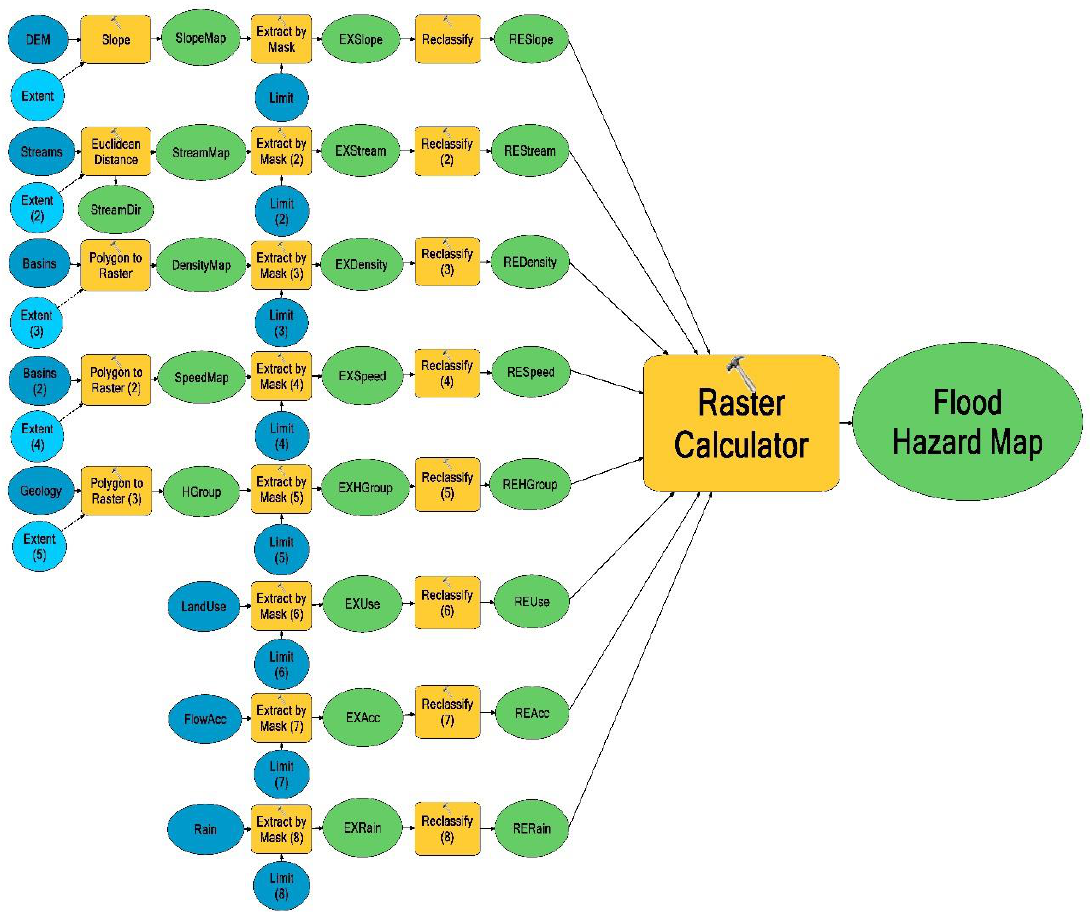
Figure 7. Structural model of flood hazard on the Al-Shamal train pathway by integrating multicriteria analysis based on geographic information systems (GIS-MCDA) and